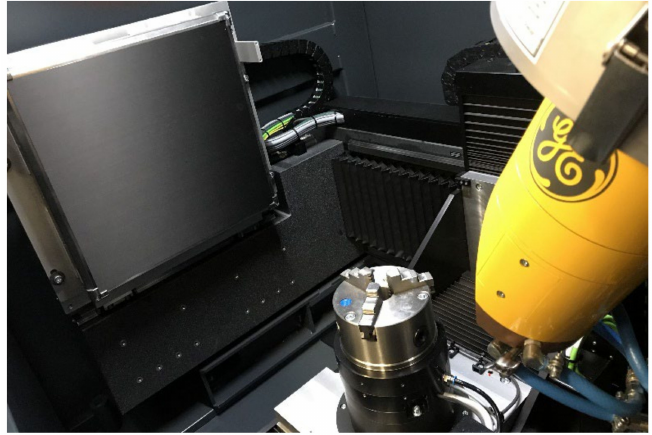
Figure 2. The tomographic chamber of the cone beam